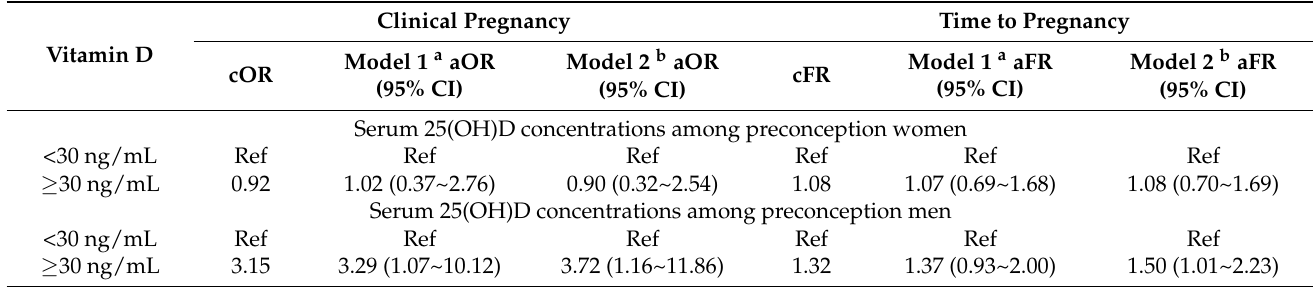
Table 2. Associations of serum 25(OH)D concentrations among preconception couples with clinical pregnancy and time to